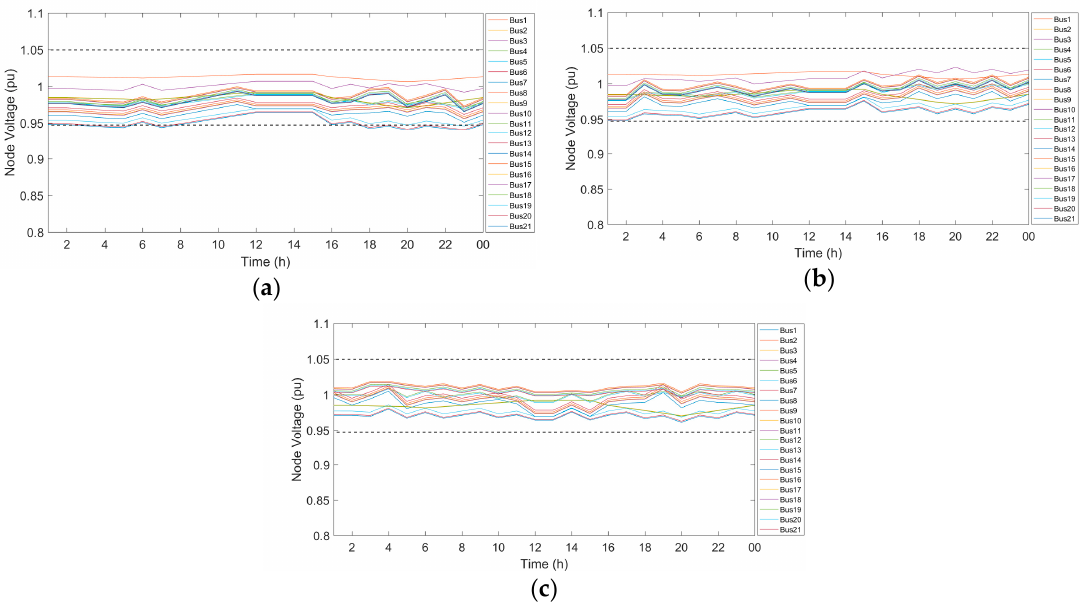
constraint of 𝑔 (cid:3004) ).